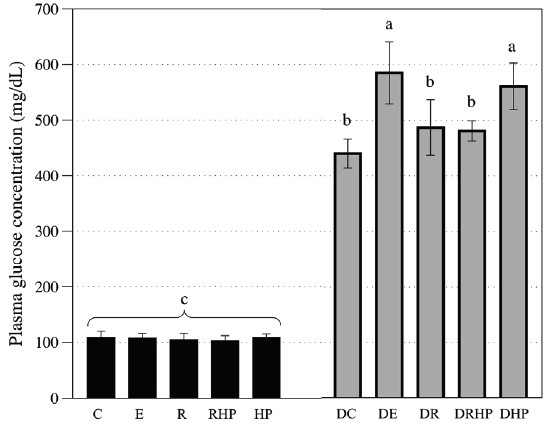
Figure 2 - Eff ects of free and resveratrol-hydroxypropyl-β- cyclodextrin administration on plasma glucose concentration of non-diabetic and diabetic rats. data are mean ± standard deviation (Sd) for 5-7 animals in each group. data from blood glucose are expressed as mg/dl. C (Control), e (ethanol), R (Resveratrol), RHP (Resveratrol-hydroxypropyl- β-cyclodextrin), HP (Hydroxypropyl-β-cyclodextrin), DC (diabetic control), de (diabetic ethanol), dR (diabetic resveratrol), dRHP (diabetic resveratrol-hydroxypropyl- β-cyclodextrin) and DHP (Diabetic Hydroxypropyl-β- cyclodextrin). Groups with diff erent letters have signifi cant diff erences ( p < 0.05) (one-way ANOVA followed by Tukey